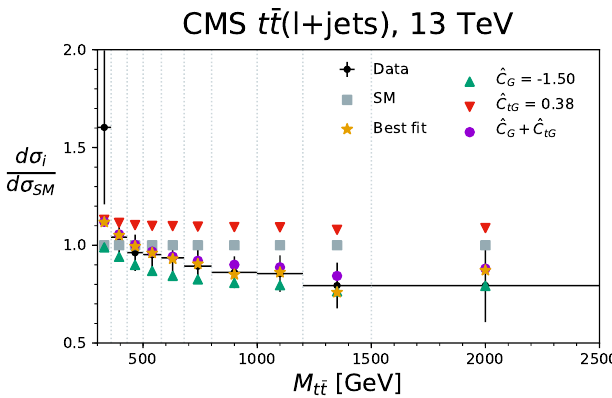
Figure 9 . The measurement of the t ¯ t invariant mass distribution in the lepton+jets channel at 13 TeV by the CMS experiment [53] compared to the SM prediction at the NNLO QCD + NLO EW level [234]. Also shown are predictions corresponding to the best-fit values for ˆ C triangles), ˆ C (red downward triangles), their combination (purple circles) and the global best-fit tG point in the full parameter space (orange